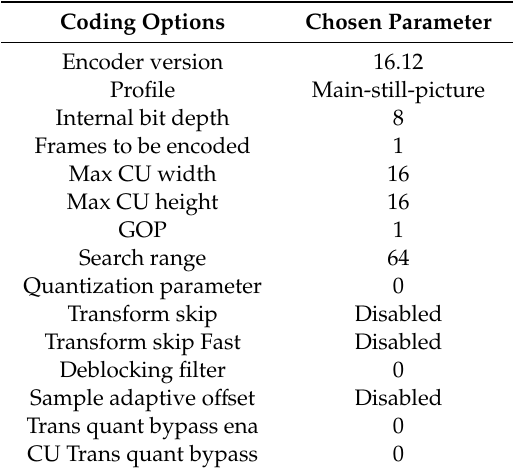
Table 3 . Summary of the HM 16.12 reference software encoder configuration. Table 3. Summary of the HM 16.12 reference software encoder configuration.